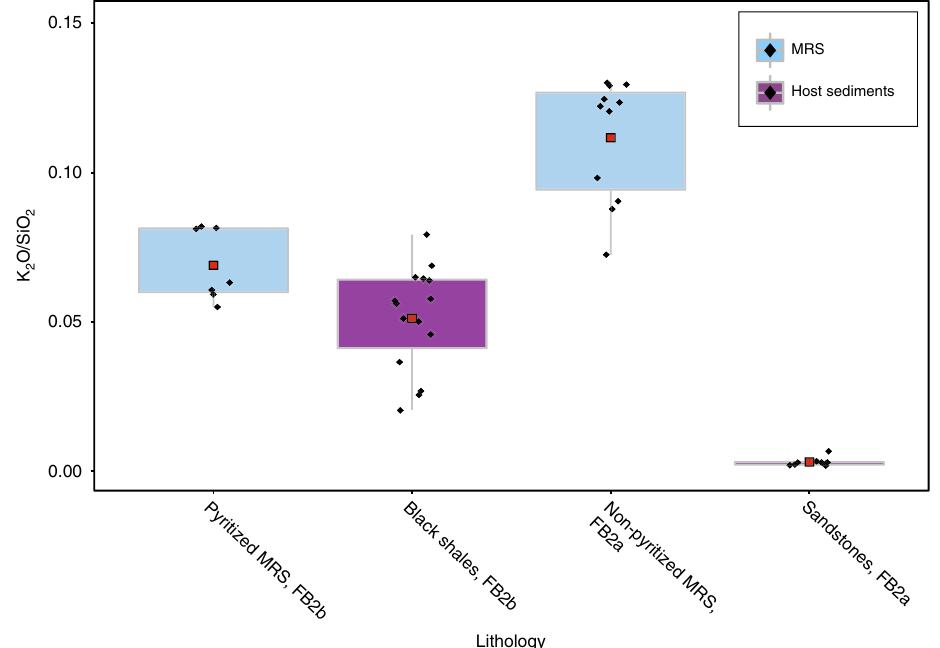
Fig. 3 K 2 O/SiO 2 ratios from mat-related structures and host sediments. Pyritized MRS are hosted by black shales and non-pyritized MRS are observed on bedding surface of sandstones. The data for each lithology are represented as box plots with a red square showing the mean, black diamonds corresponding to individual samples, 50% of the data are shown as a box and whiskers extend to 1.5 times the interquartile range